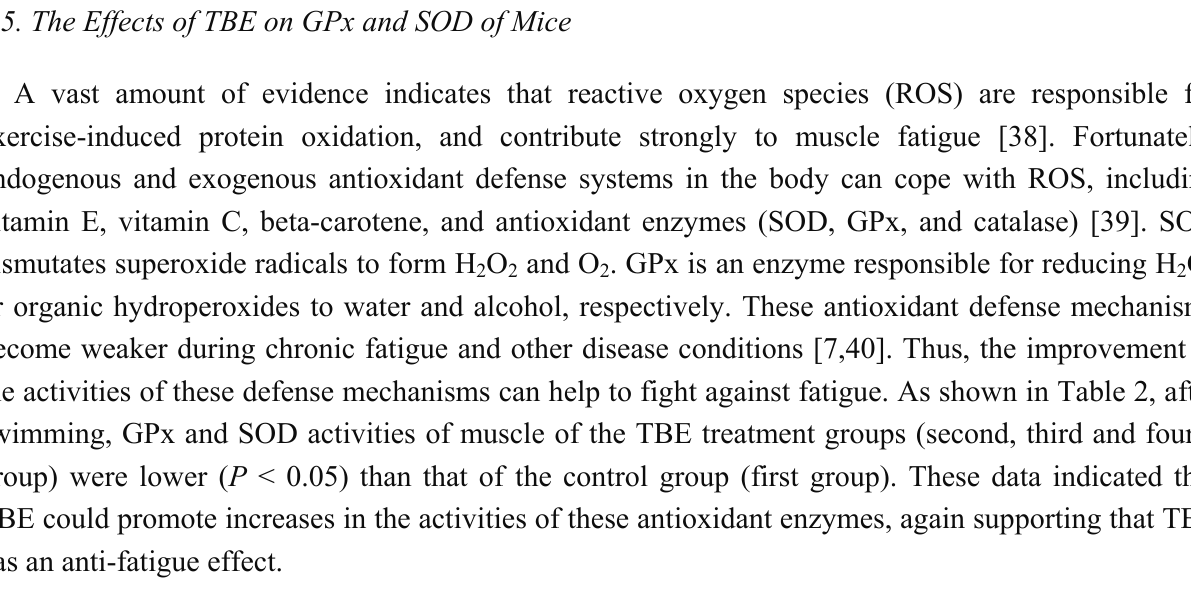
Table 2. The effects of TBE on glutathione peroxidase (GPx) and superoxide dismutase (SOD) of skeletal muscle of mice. Values are means ± SD. * P < 0.05 when compared to the control group (first